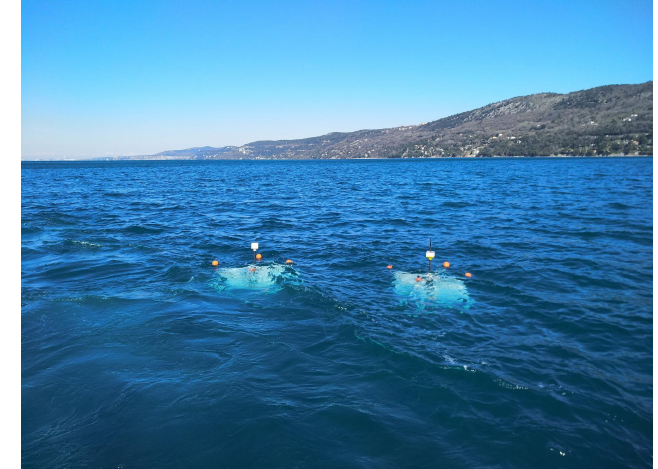
Figure 3. Drifters in the water during the March 2018 experiment in the Gulf of Trieste